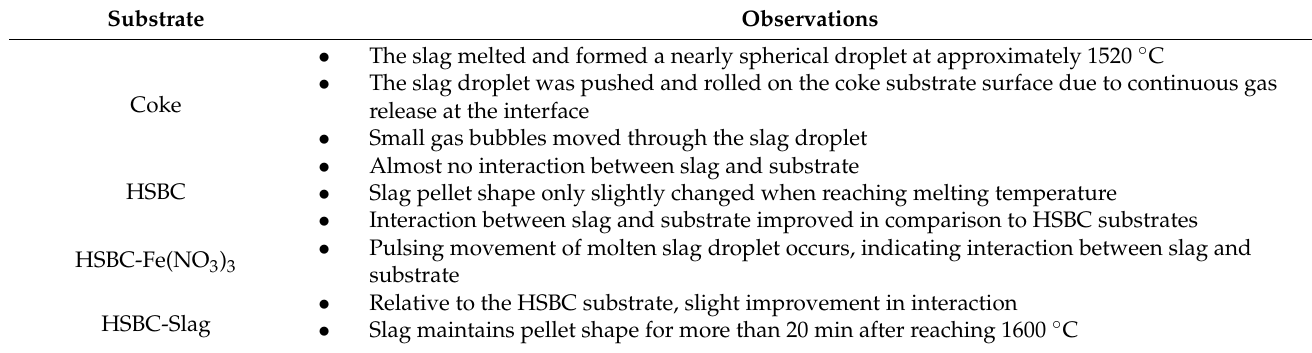
Figure 5. Comparison of the interaction between slag and carbonaceous substrates, with a focus on bio-char ash modification. With reference to Figure 5, the observed interaction between the slag and different substrates is summarized in Table 10. Table 10. Summary of interfacial interaction